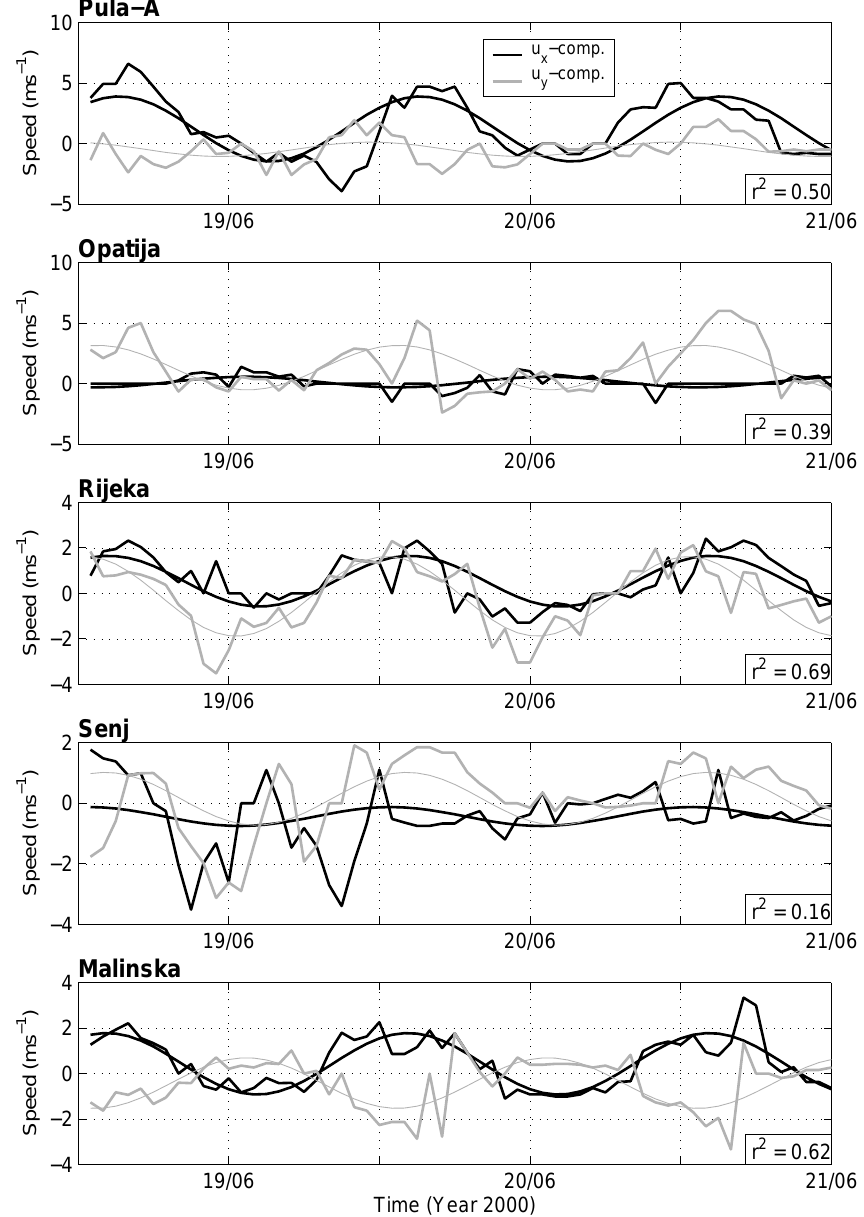
Fig. 4. Measured hourly values of the near-surface wind and the corresponding 24-h harmonics fitted ( u x – east-west wind component; black, u y – north-south wind component; grey) at selected stations from noon, 18 June 2000, until midnight, 20 June 2000. The correlation coefficient squared is indicated in the lower right